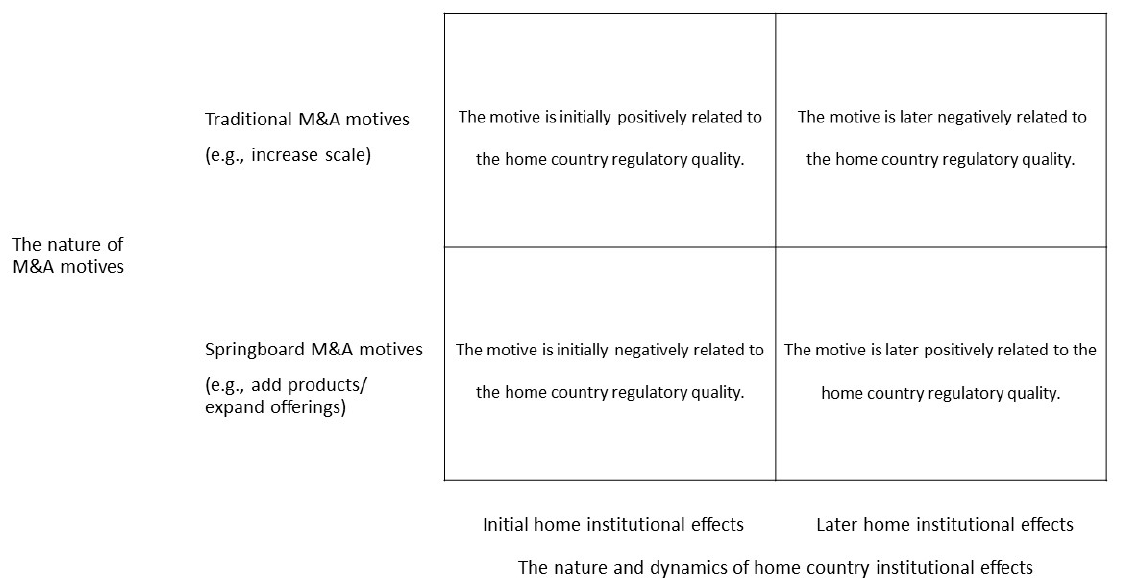
Figure A1. A typology of the cross-border M&A motives and the dynamics of home country institutional effects.